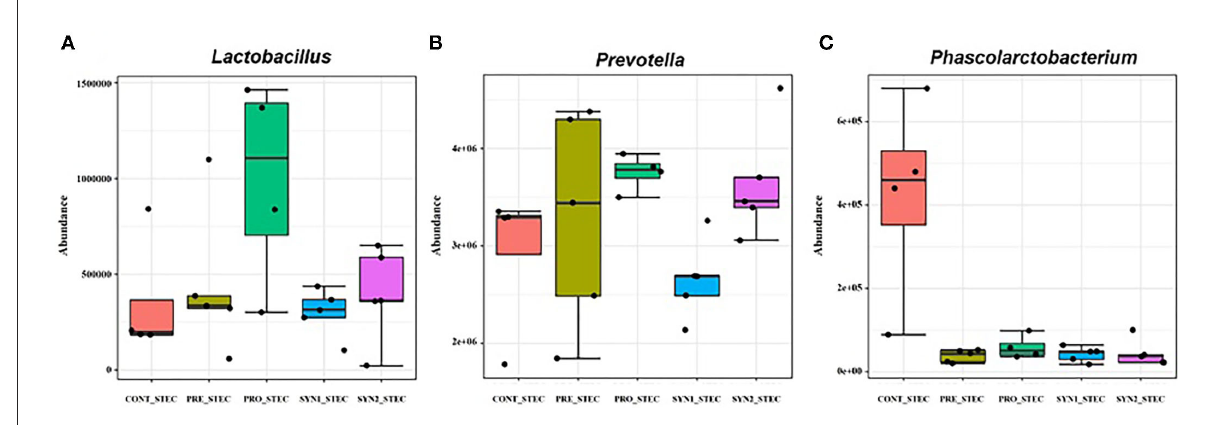
FIGURE5 Box plots showing significantly different genera in weaned pigs supplemented with prebiotics, probiotics or synbiotics with STEC challenge. Abundance of bacterial genera including (A) Lactobacillus , (B) Prevotella , (C) Phascolarctobacterium were compared between PRE, PRO, SYN1 and SYN2 in comparison to the STEC-challenged CONT group.